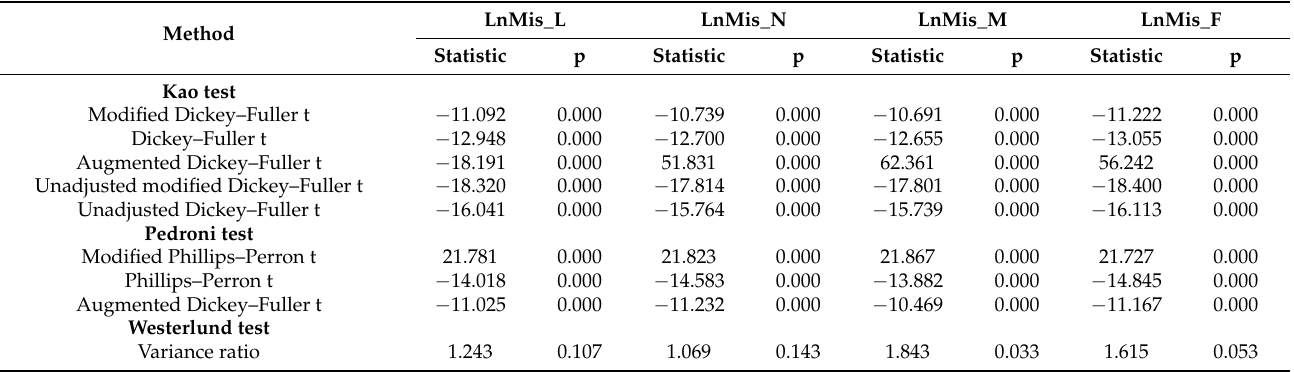
Table 2. Panel cointegration tests